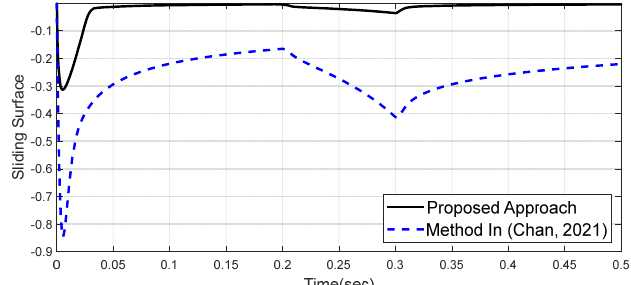
Figure 9. Sliding surfaces [1] .